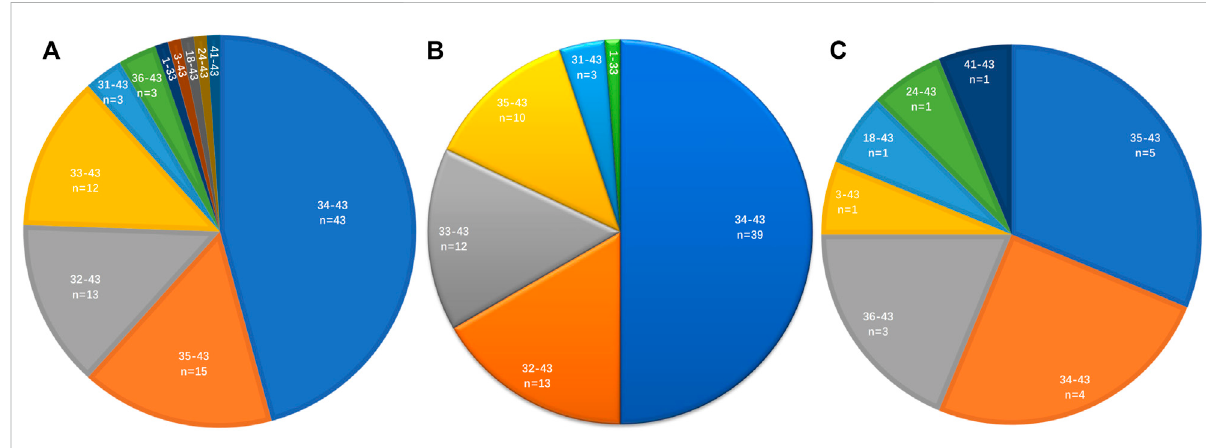
FIGURE 3 Distribution of ROS1 breakpoints. (A) ROS1 breakpoints of ROS1 fusion patients. (B) ROS1 breakpoints of reported ROS1 fusion types. (C) ROS1 breakpoints of novel ROS1 fusion types in